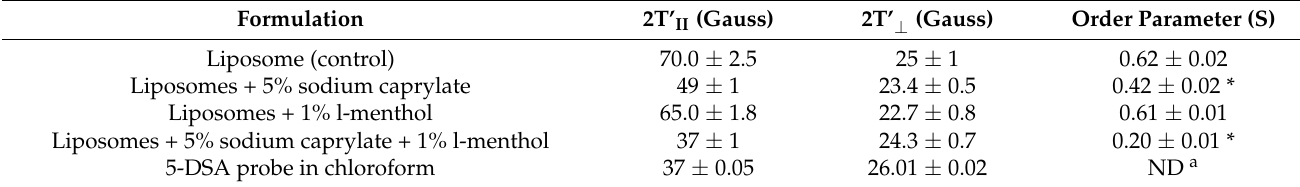
Table 1. Parameters derived from ESR spectra for 5-DSA-labeled buccal liposomes exposed to permeation enhancers.